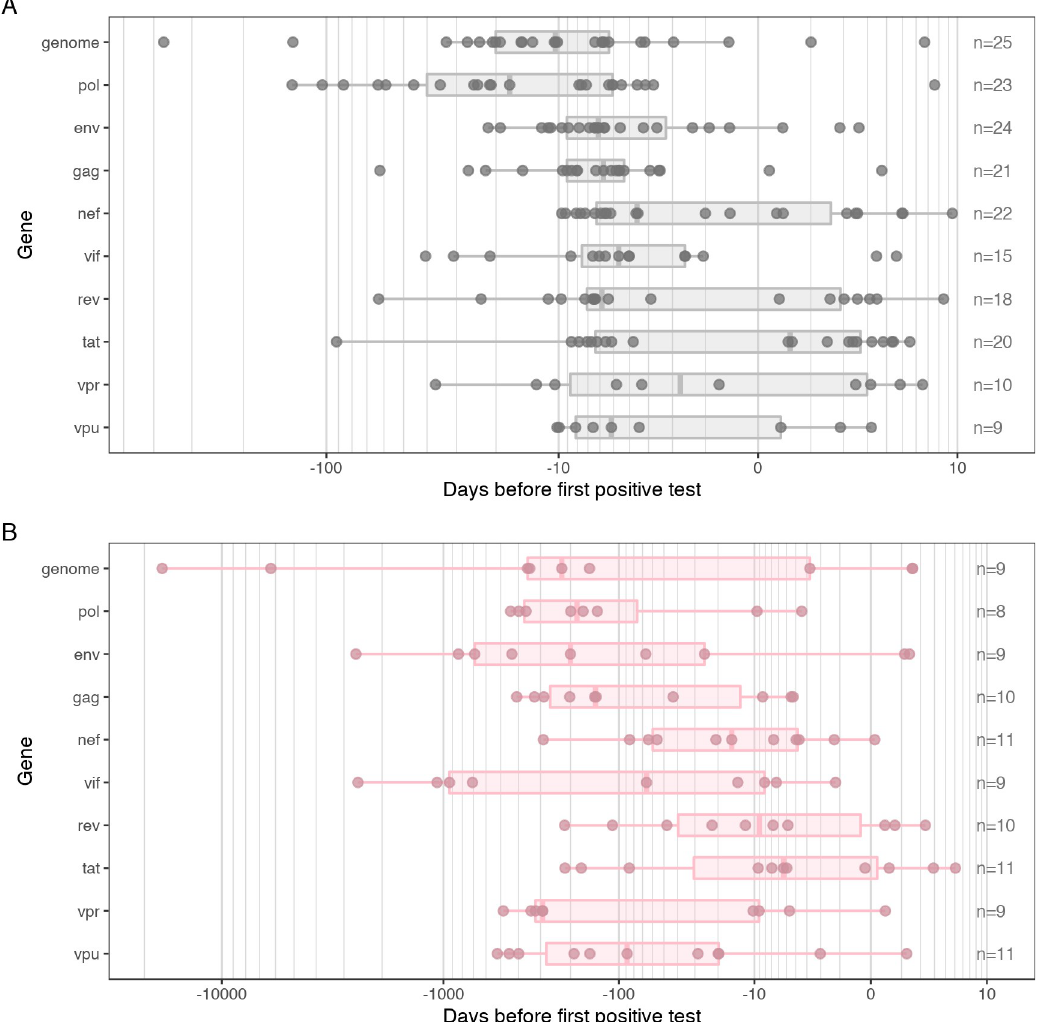
Fig 3. Estimates of the date of infection by gene and founder type. Points are colored gray for participants with infections founded by a single variant (A), and pink for those founded by multiple variants (B). The scale is shown with a power modulus transformation for visibility, and is different for infections with single or multiple HIV-1